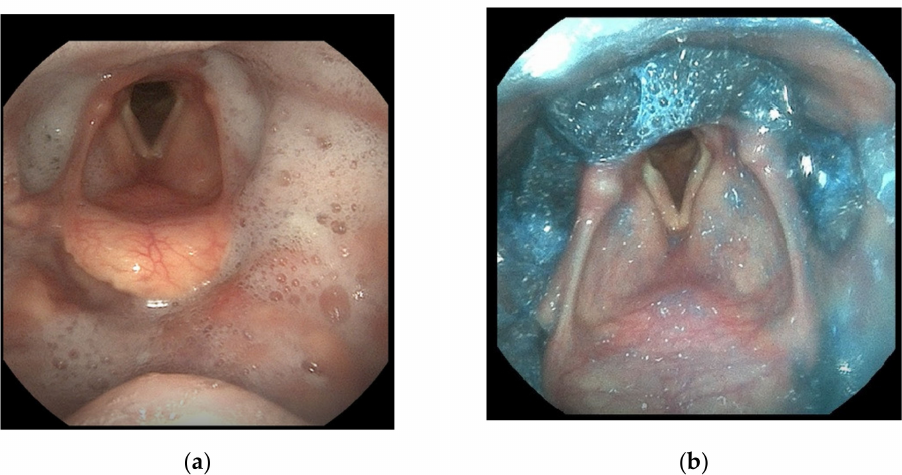
Figure 1. Thin liquid (milk) ( a ) and moderately thick liquid ( b ) samples revealed delayed bolus transit to the pharynx. Residua in the vallecula, pyriform sinuses, and